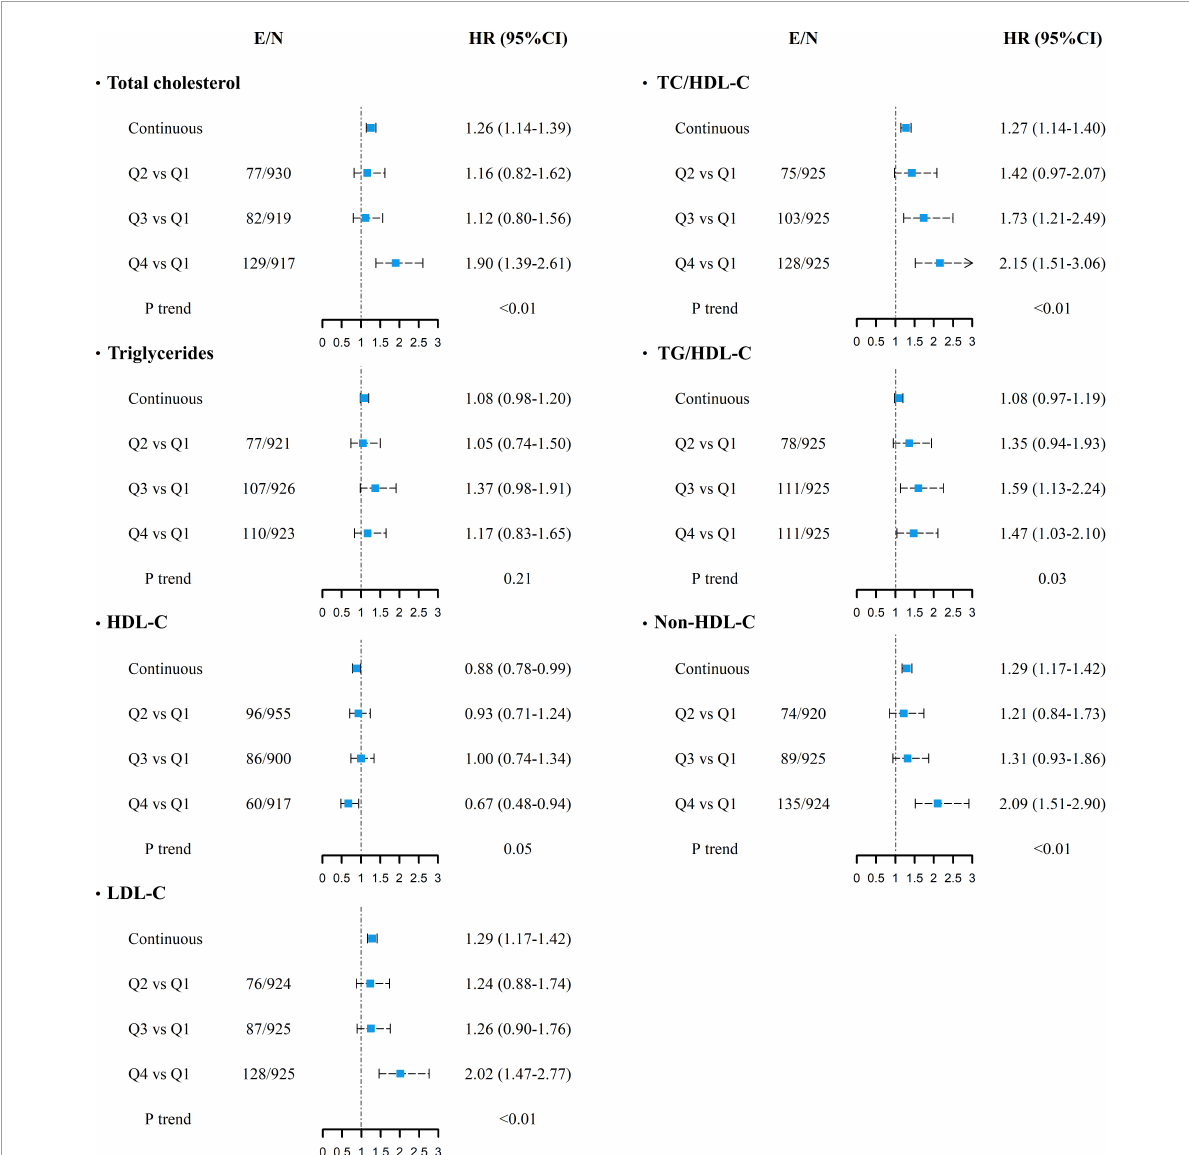
FIGURE1 Multivariable-adjusted HRs (95% CI) for incident cardiovascular diseases associated with mean lipid levels of TC, TG, HDL-C, LDL-C, TC/HDL-C, TG/HDL-C, and non-HDL-C. Adjusted for age, sex, smoking status, diabetes mellitus, family history of CVD, use of anti-hypertensive drugs, lipid-lowering drugs, and average body mass index and systolic blood pressure. P for trend was calculated across quartiles using multivariable Cox regression model. Continuous variables are shown for each 1-SD increase. E/N, number of events per number of subjects in each category; HR, hazard ratio; CI, confidence interval; TC, total cholesterol; TG, triglycerides; HDL-C, high-density lipoprotein cholesterol; LDL-C, low-density lipoprotein cholesterol. For all lipid parameters, first quartile (Q1) is the reference category.